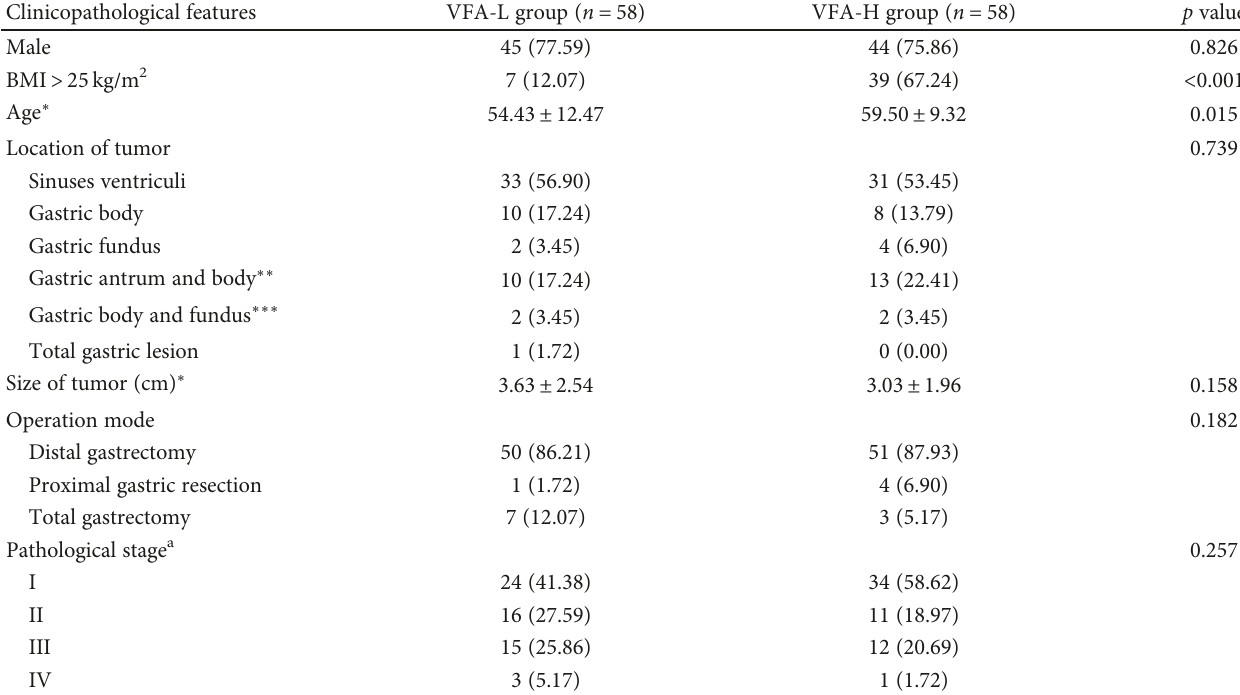
Table 1: Comparison of features between the low-VFA group and high-VFA group (cases (%)).